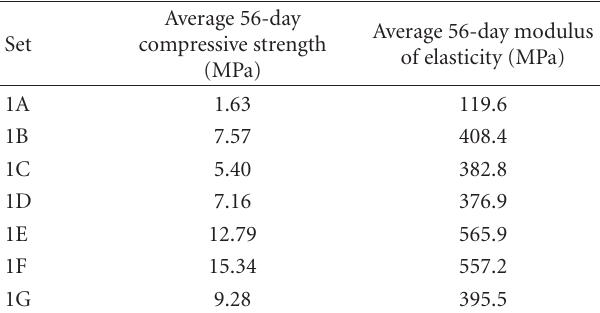
Figure 2: Early compressive strength of hydrated spray dryer ash with fibers. Table 3: Average 56-day compressive strength and modulus of elasticity measured from cube